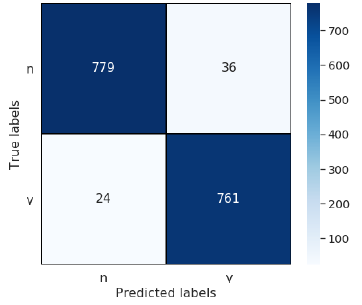
Figure 4. Confusion matrix: Neutral particles classification after testing 1,600